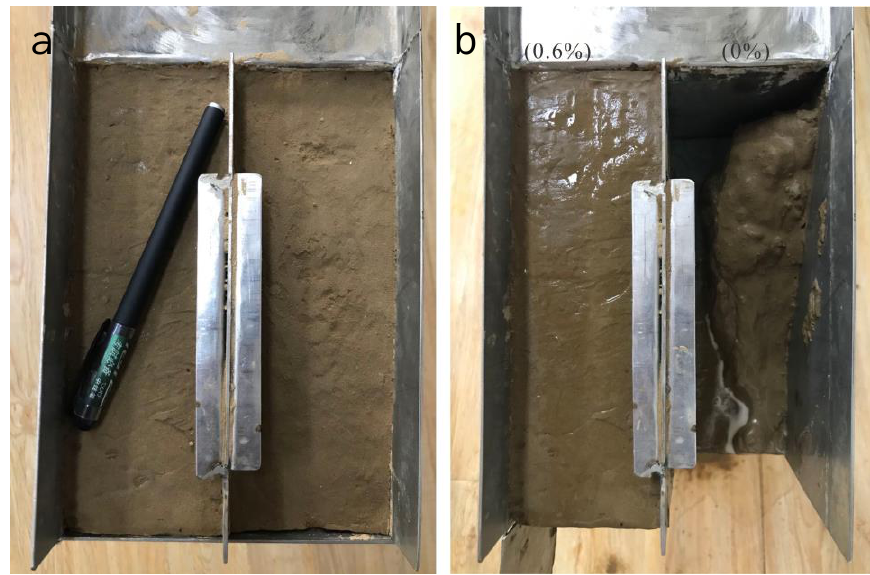
Figure 12. Soil anti-scour test: ( a ) before the test; ( b ) after the test.